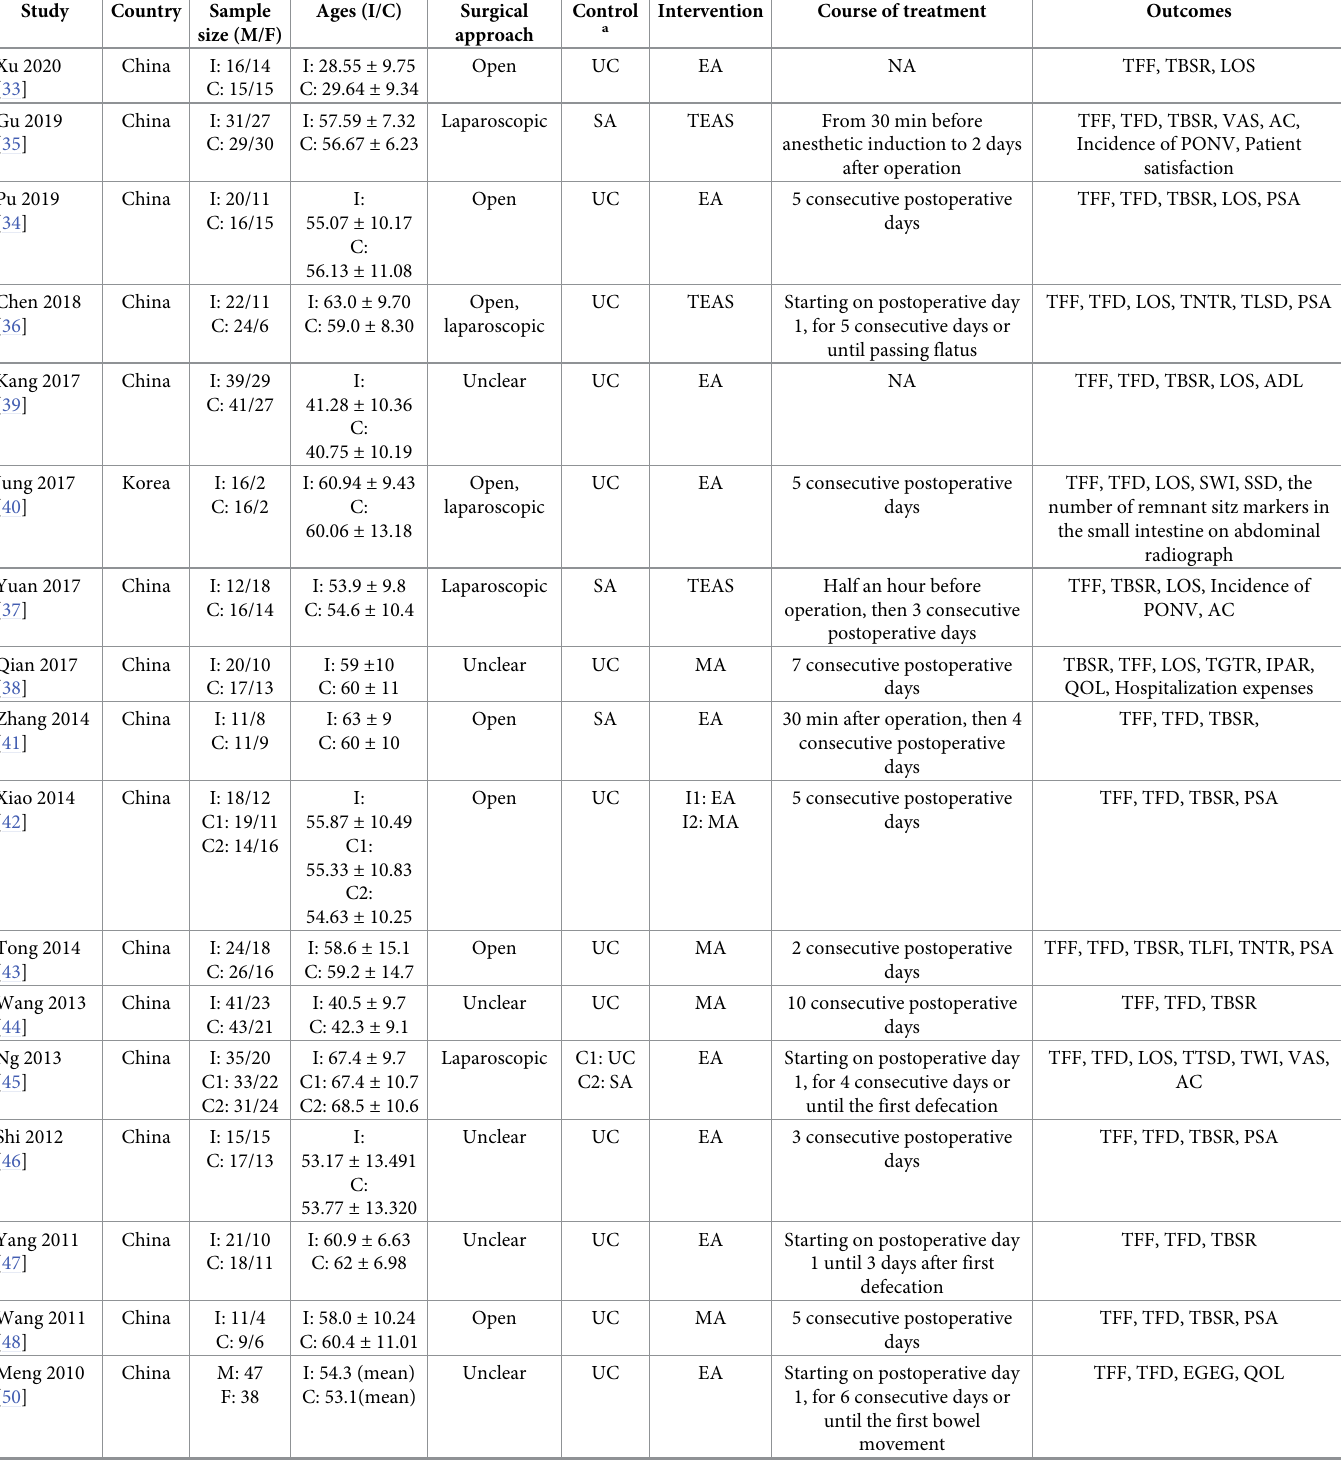
Table 1. Characteristics of included studies in the systematic review and meta-analysis. Study